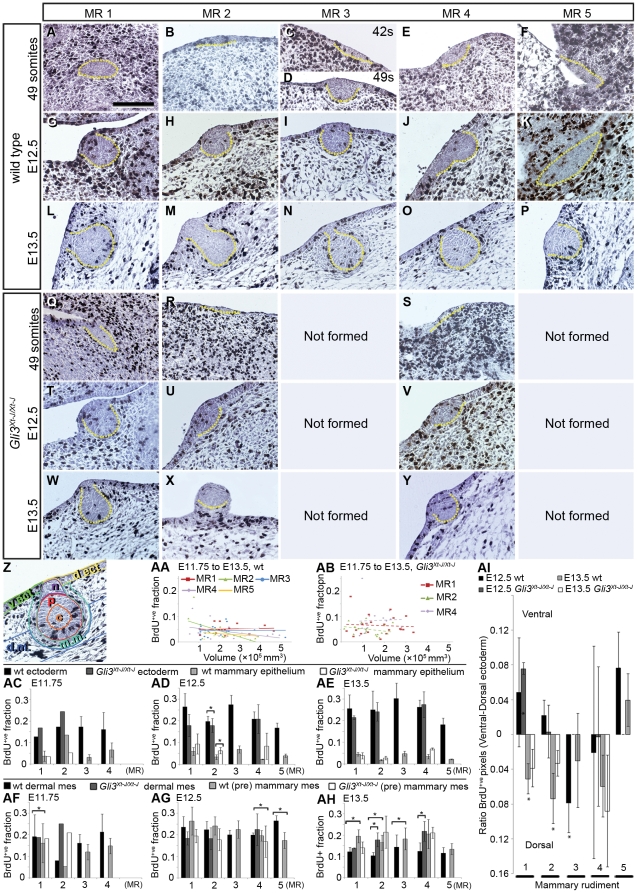
Proliferative activity in wt and Gli3Xt-J/Xt-J MRs and adjacent tissues.
A–Y: Immunohistochemical detection of BrdU-incorporation (black) at 2 hours post-labeling, with hematoxylin-counterstain (blue). Dashed yellow lines outline the MR. Left is ventral ectoderm, in some panels indicated with *. Scale-bar in A: 100 µm in A–Y. Z-AI: Quantification of BrdU-incorporation in entire MRs and their adjacent tissues, represented in A–Y. Z: Quality control image of a wt E13.5 MR1 as generated with our software. Colored outlines demarcate dorsal ectoderm (d.ect., green), ventral ectoderm (v.ect., yellow), MR core (c, orange), MR periphery (p, red), MR neck (n, purple), mammary mesenchyme (m.m., turquoise), and dermal mesenchyme (d.m., blue). AA,AB: Relationship between MR-volume and BrdU-incorporation. AC–AE: The BrdU+ve fraction of all nuclear pixels in MRs and their adjacent ectoderm. AF–AH: The BrdU+ve fraction of all nuclear pixels in ‘pre’mammary or mammary and dermal mesenchyme (mes). AI: Differences in BrdU-incorporation between the ventral and dorsal ectoderm (fraction in dorsal side subtracted from fraction in ventral side per embryo). Asterisks denote a significantly difference (p<0.05) between both sides.